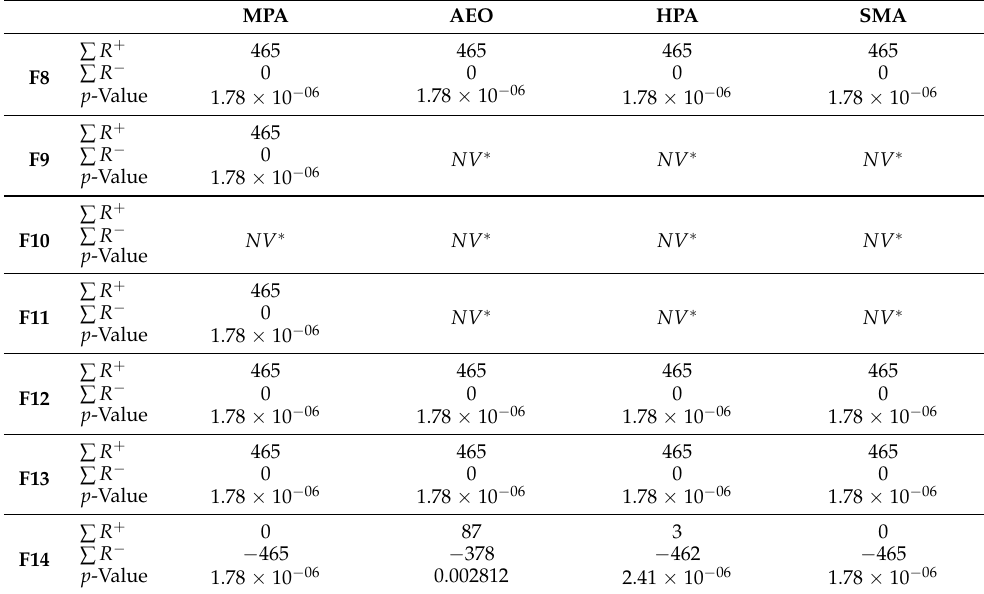
Table 6. Nonparametric test using WSRT values for multimodal benchmark